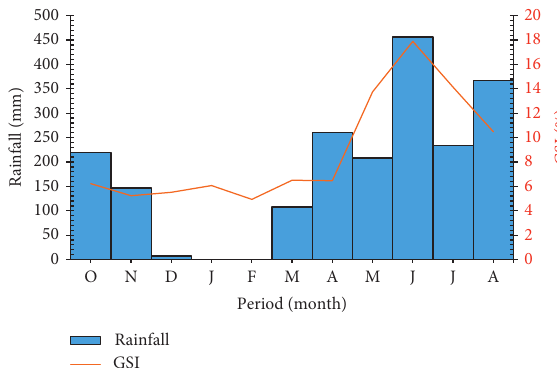
Figure 7: Correlation between the gonadosomatic index of C. nigrodigitatus and rainfall in the Nkam River. Table 2: Monthly variation of sex ratio in C. nigrodigitatus